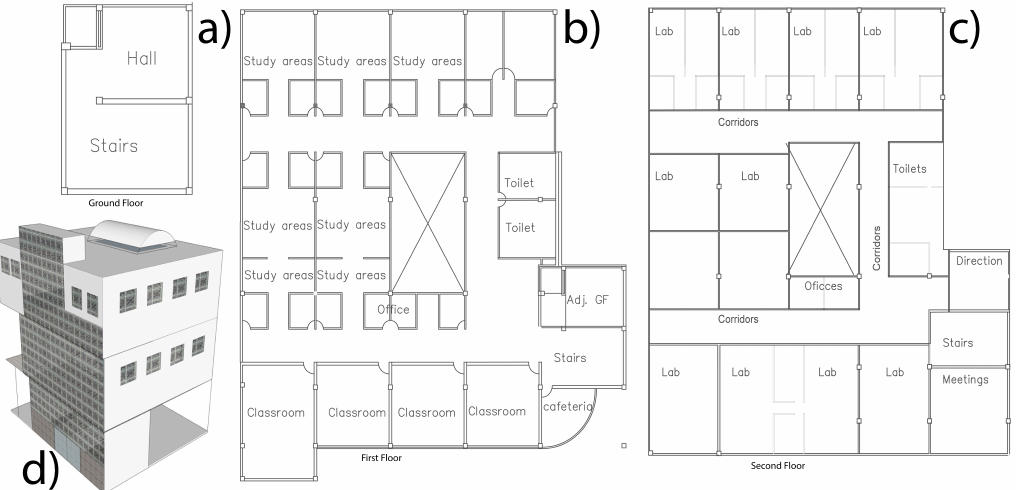
Figure 2. Architectural blueprints of the second case study building (Mexico): ( a ) ground floor and ( b ) first floor ( c ) second floor and ( d ) Numerical model geometry: Northeast view. The building in Spain is made with three different types of envelopes: the vertical facing walls, the floor, and the roof. In Table 1 we indicate that their respective thicknesses (t) are 46.5 cm, 30.4 cm and 185 cm. The building in Mexico Table 2 has four types of envelopes: internal (9 cm) and external (35 cm) walls, as well as 10 cm-thick divisions. In this case, the same materials were used in the floor and the roof, with a total thickness of 40 cm.